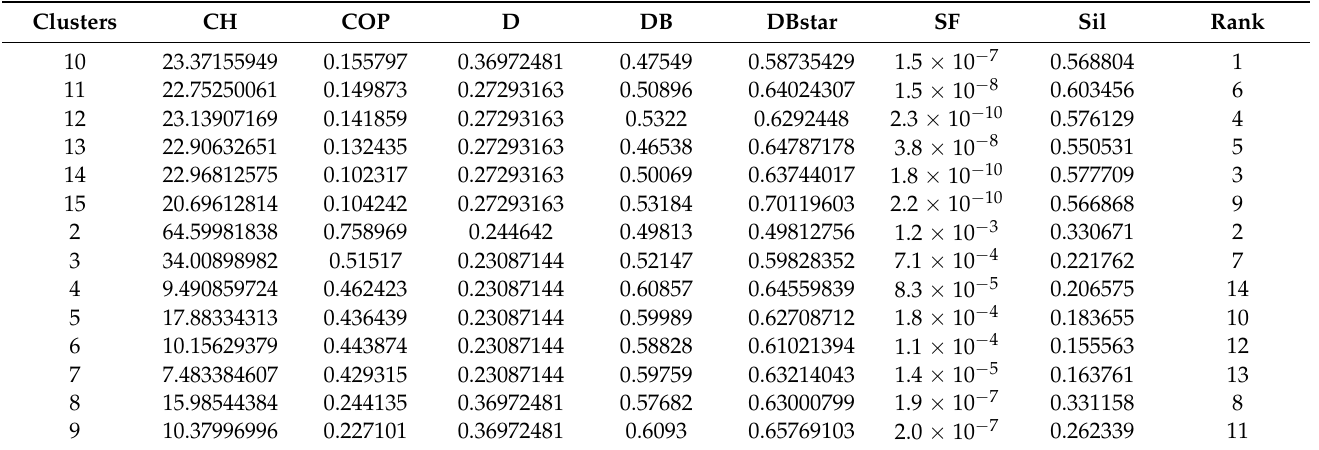
6 Table 9. CVI results for males aged 20 to 60.